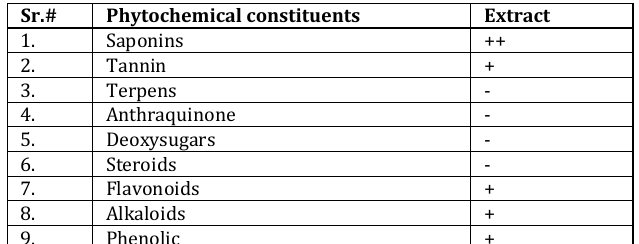
Table 1: Phytochemical analysis of Azadirachtaindica (Neem) Sr.#